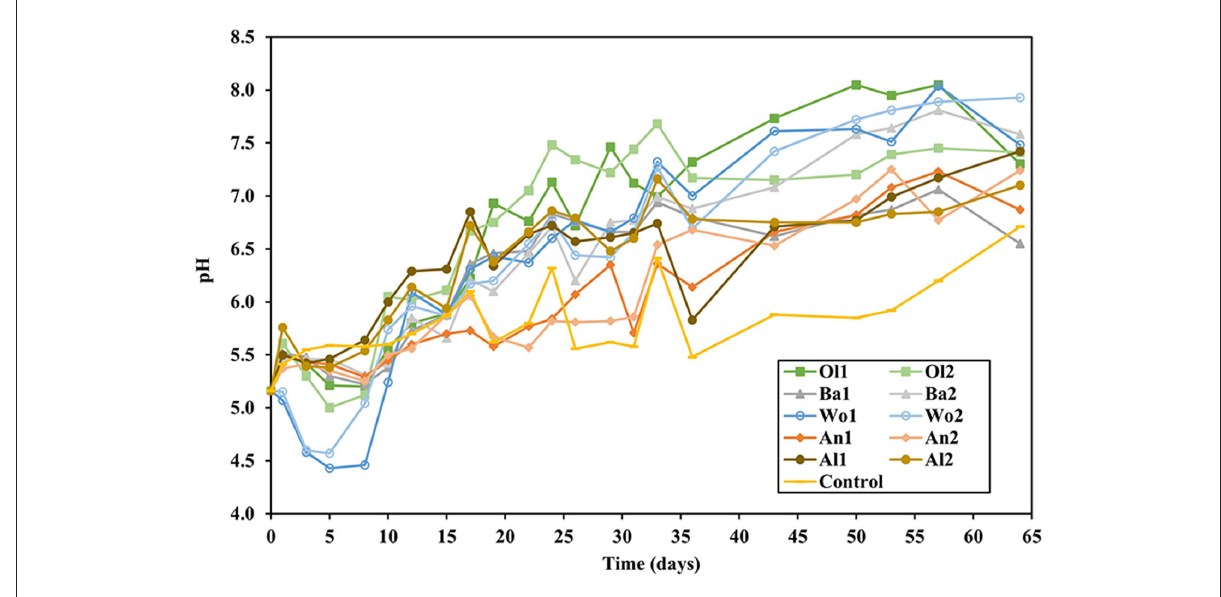
FIGURE3 Development of pH measured in leachate samples over time.